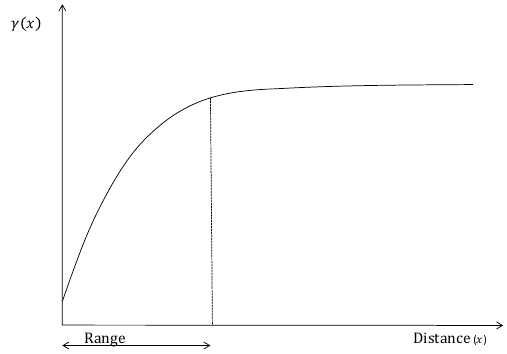
Figure 5. Sketch of semi-variogram: the range is the distance ( x ) from the origin beyond which the semi-variogram γ (x) tends to